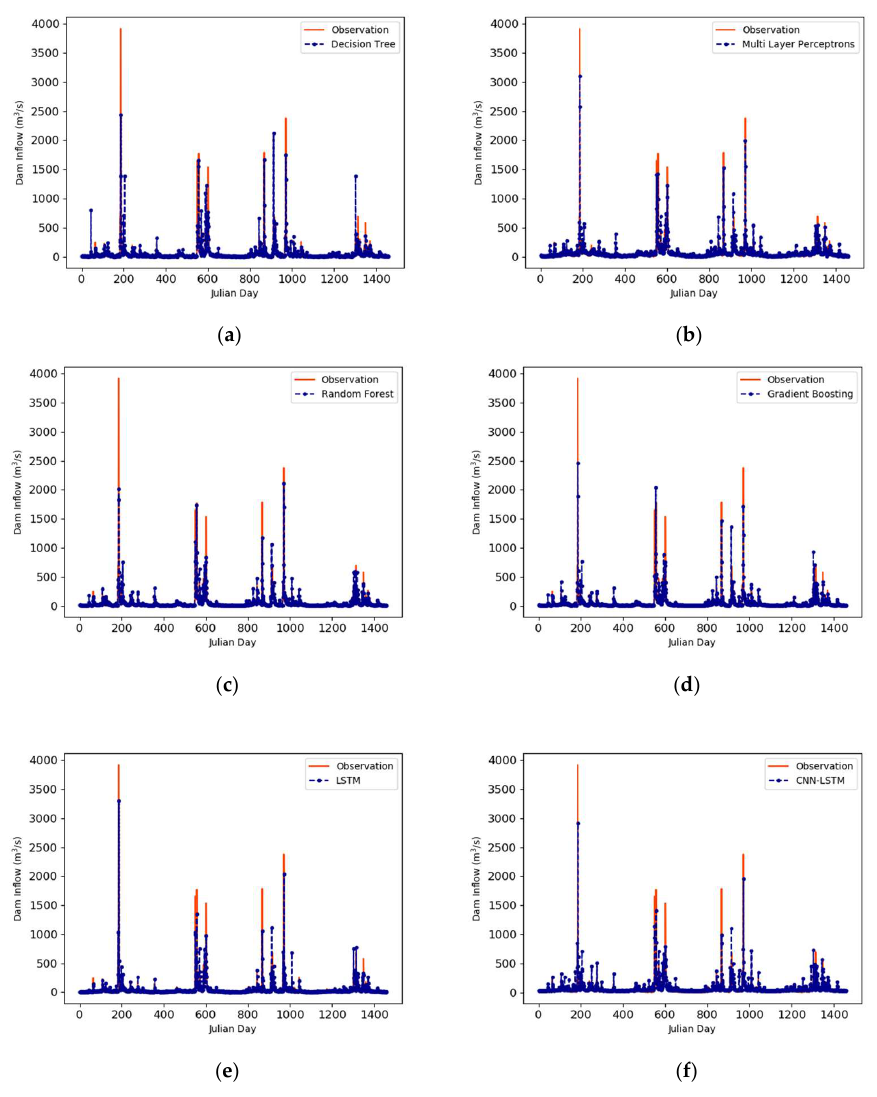
Figure 8. The comparisons of forecasting results using machine learning of ( a ) decision tree, ( b ) multilayer perceptrons, ( c ) random forest, ( d ) gradient, ( e ) LSTM, and ( f ) CNN–LSTM.